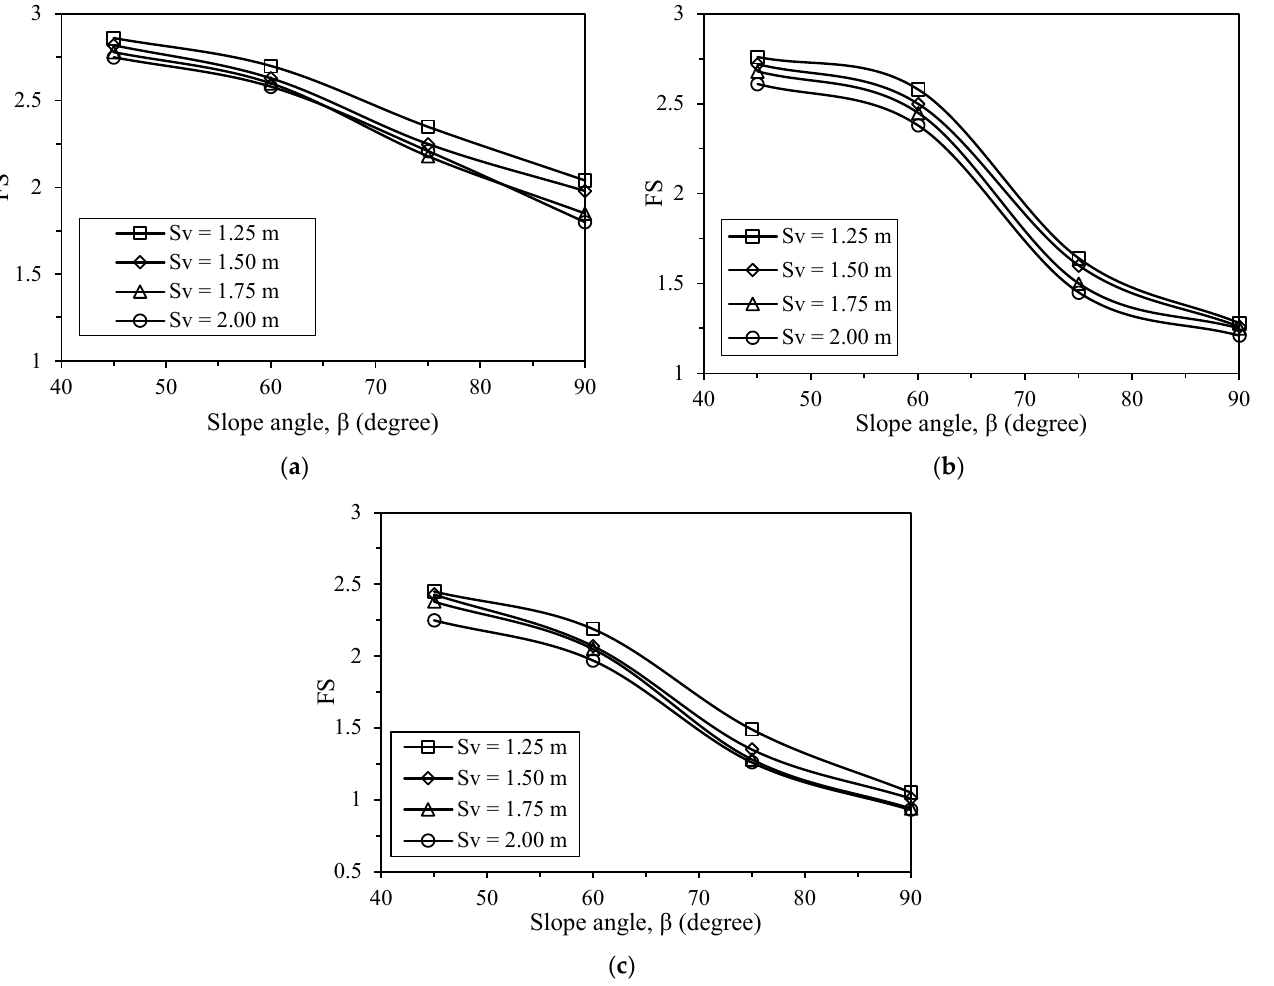
Figure 9. Effect of vertical nail spacing on FS of slope with different backslope inclinations: ( a ) α = 0°, ( b ) α = 10°, and ( c ) α = 20°.